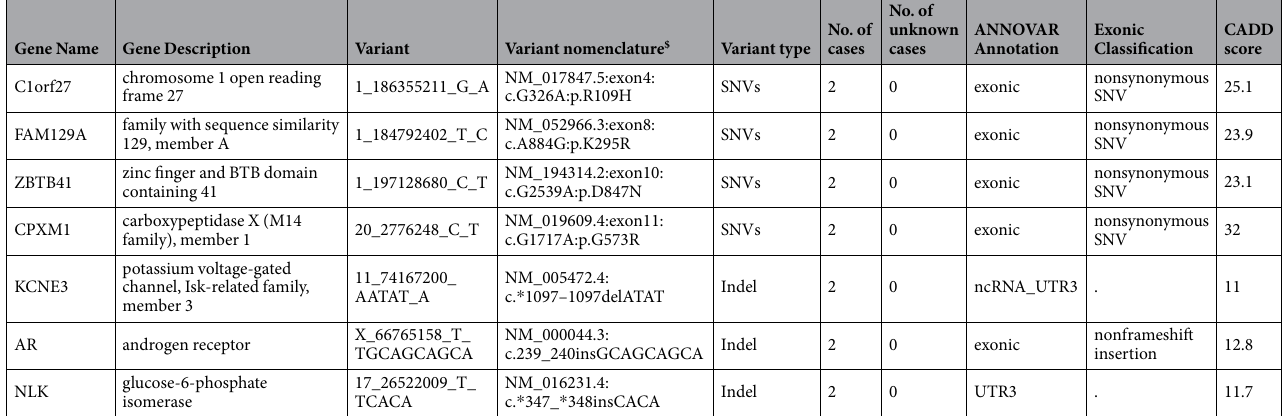
Table 3. Overview of the 7 top-ranked germline variants detected in the PTC family. $ - as per guidelines of the Human Genome Variation Society (HGVS, website